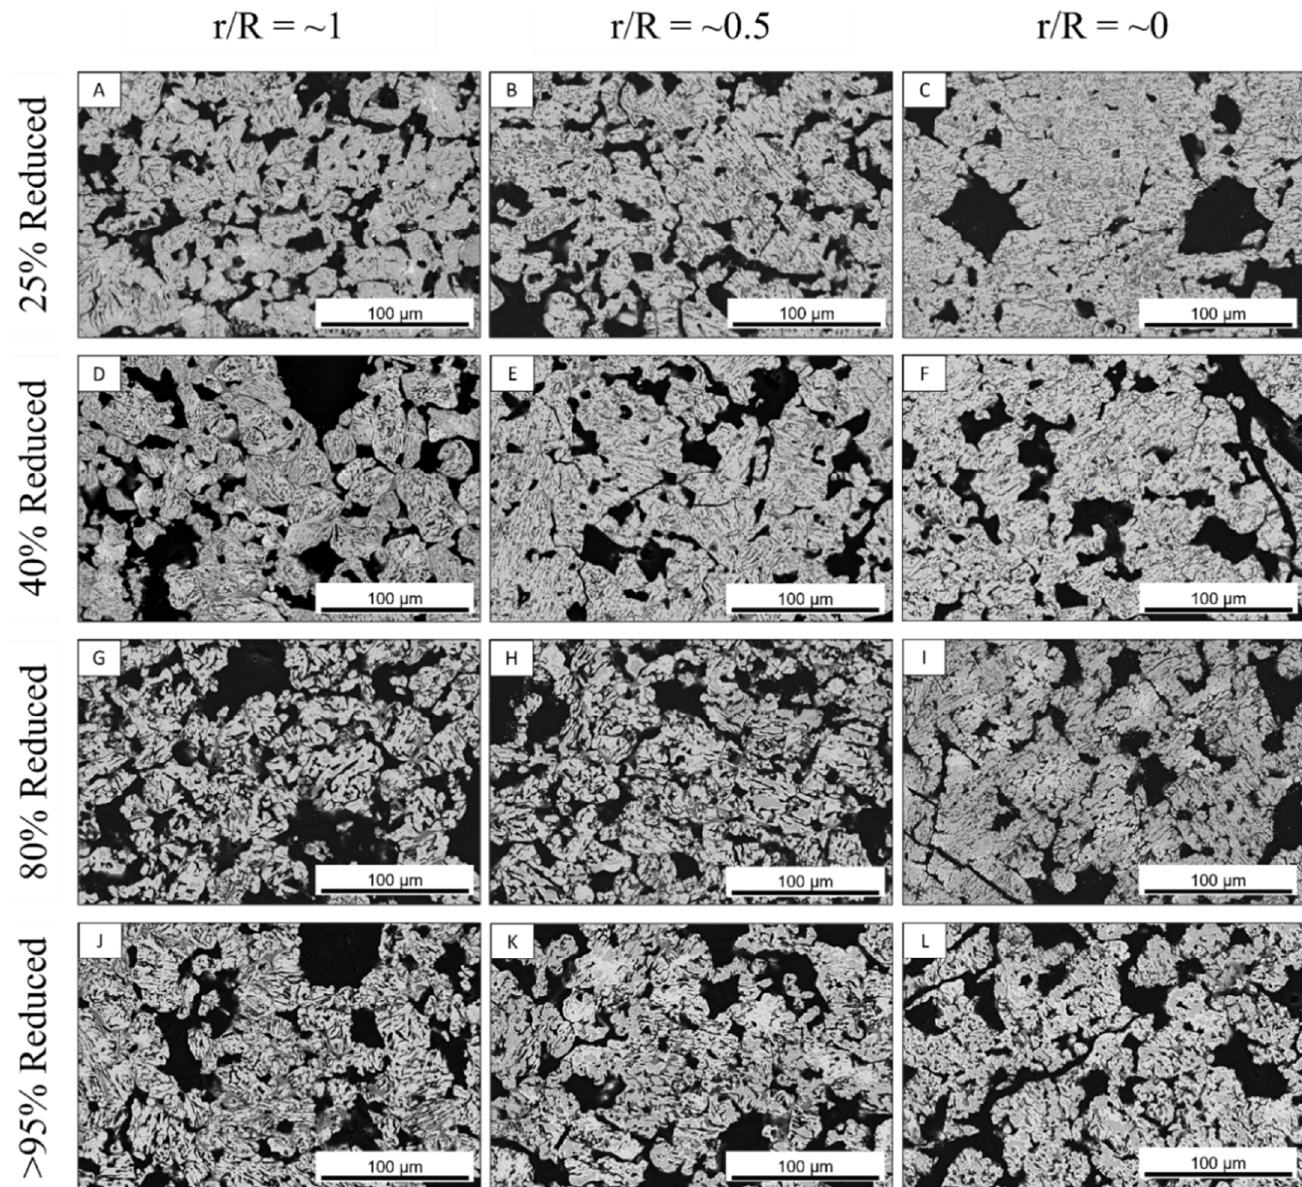
Figure 4. SEM Images of partially reduced pellet using pure H 2 gas. SEM Images of 25% H 2 reduced pellet taken in ( A ) shell region, ( B ) middle region and ( C ) core region, 40% reduced pellet taken in ( D ) shell region, ( E ) middle region and ( F ) core region, 80% reduced pellet taken in ( G ) shell region, ( H ) middle region and ( I ) core region, >95% reduced pellet taken in ( J ) shell region, ( K ) middle region and ( L ) core region.